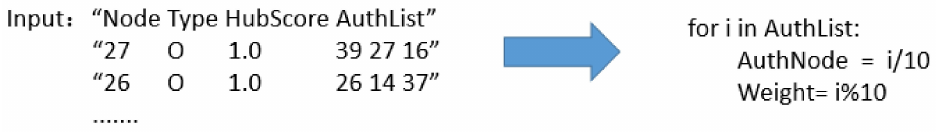
Figure 6. Iterative code of weighted HITS algorithm based on the Hadoop